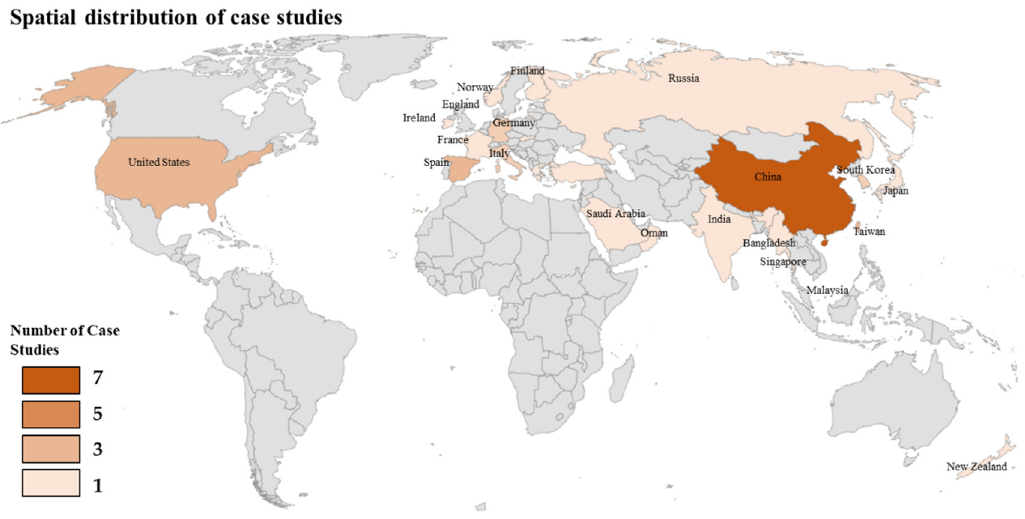
Figure 5. Spatial distribution of past case studies conducted on digital twins for management of extreme climate events in smart